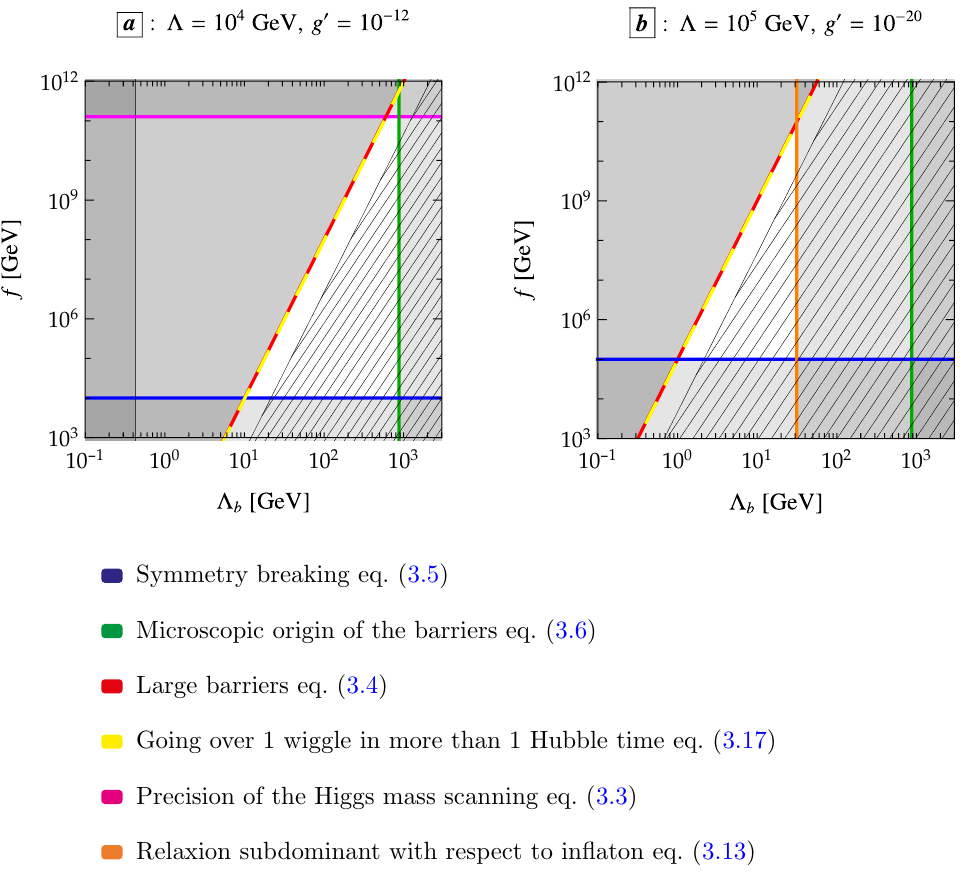
Figure 16 . Details of the origin of the constraints delimitating the red regions presented in sec- tion 3.1 and (cid:12)gure 4, for benchmark points a , and b , corresponding to the case where relaxation happens through Higgs-dependent barriers, during a stage of in(cid:13)ation, where the relaxion is a sub- dominant component of the energy density of the universe and where the relaxion stops because of large barriers .